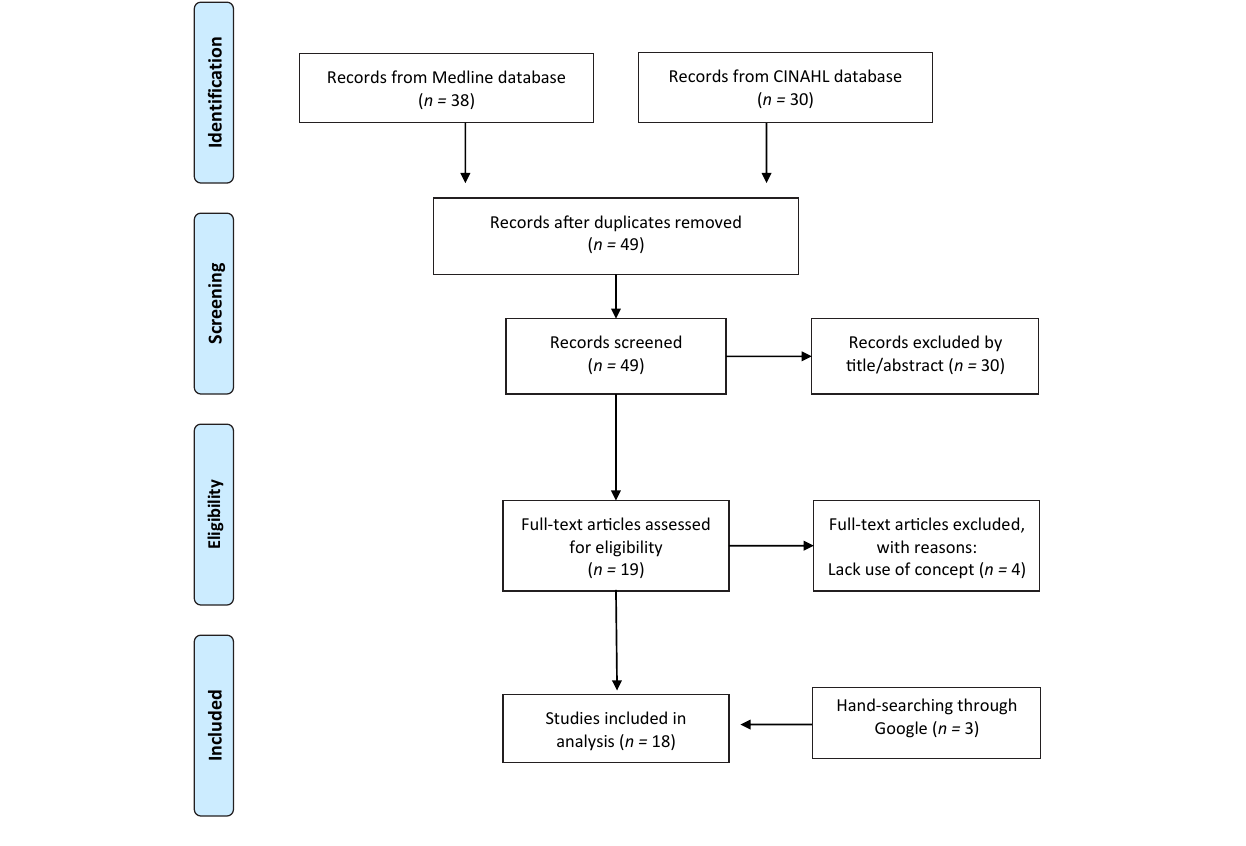
FIGURE 1 | PRISMA flow